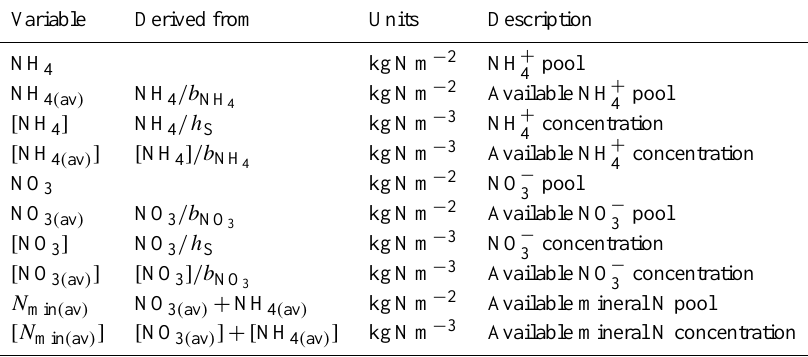
and b NO can be found in 4 3